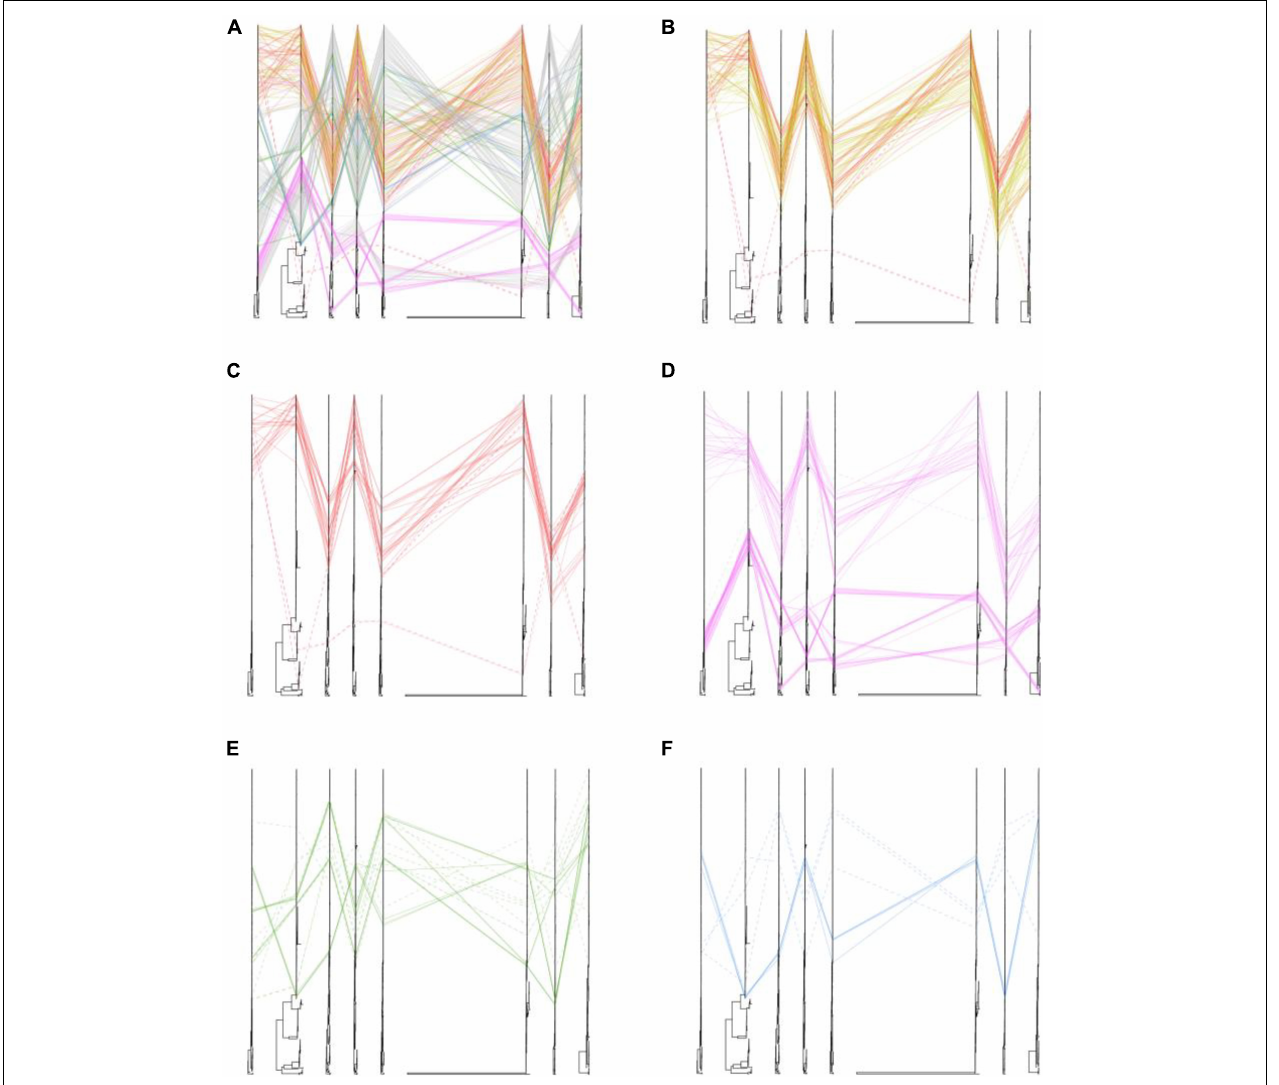
FIGURE 3 | Phylogenetic incongruence analysis of clade 2.3.4.4b H5 subtype influenza viruses during 2020–2021. Maximum likelihood trees for the HA and NA segments as well as all the internal genes, PB2, PB1, PA, NP, MP, and NS from equivalent strains were connected across the trees. Lines are colored according to the different locations. Strains that are clustered together are shown with a solid line, and strains that cannot be classified to any cluster are shown with a dashed line. (A) Phylogenetic incongruence of all isolates. (B) Phylogenetic incongruence of clade 2.3.4.4b H5 isolates in China during 2020–2021. (C) Phylogenetic incongruence of clade 2.3.4.4b H5 isolates in China in this study during 2020–2021. (D) Phylogenetic incongruence of clade 2.3.4.4b H5 isolates in Korea during 2020–2021. (E) Phylogenetic incongruence of clade 2.3.4.4b H5 isolates in Russia during 2020–2021. (F) Phylogenetic incongruence of clade 2.3.4.4b H5 isolates in Bangladesh, Kazakhstan, and Vietnam during 2020–2021. The phylogenetic incongruence was estimated using R package GGTREE (version